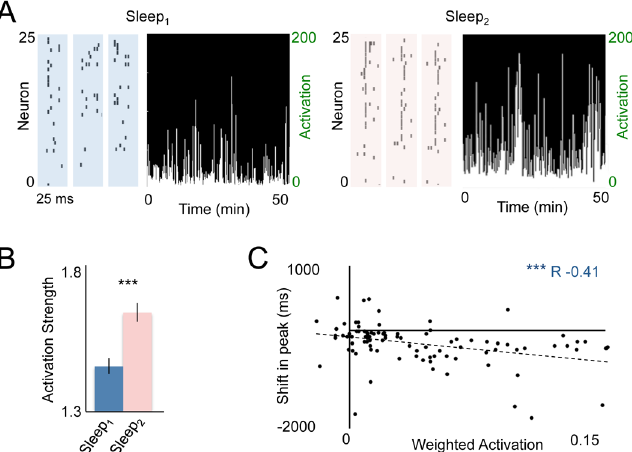
Fig 5. Reactivation of task-related neural ensembles during slow-wave sleep. (A) Example of reactivation events prior to and after learning (i.e., Sleep 1 versus Sleep 2 events in respective blue and red boxes). Also shown are the activation strengths of reactivation events during the initial NREM epochs from Sleep 1 and Sleep 2 . (B) Across all animals, there was a significant reactivation of task-related ensembles ( p < 0.001, sign-rank test). Quantification was based on the entire recorded NREM sleep. (C) Linear correlation between single neuron reactivations and neural modulation during Reach 2 . To estimate “ single neuron reactivation, ” we first calculated the overall ensemble reactivation [(mean activation during NREM from Sleep 2 ) – (mean activation during NREM from Sleep 1 )] and then multiplied this value with the principle component weight for each neuron. Plot shows the regression analysis between each neuron ’ s reactivation and subsequent temporal shift (r = -0.41, p < 0.001). Error bars show S.E.M. * p < 0.05, ** p < 0.01, *** p <